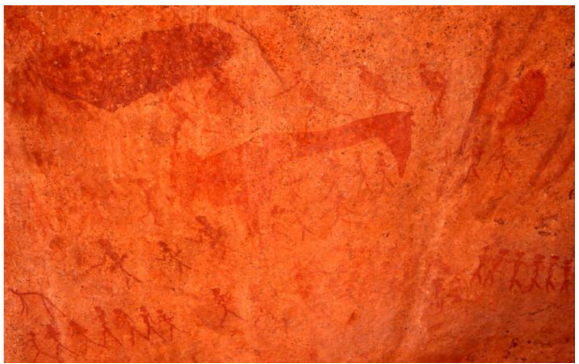
Figure 4. Ochre bushmen rock painings from Brandberg, Namibia. The bushmen mixed red ochre with blood or egg white to paint social and ritual activities, or the mythical rain bringing giraffe as seen here (Helmut